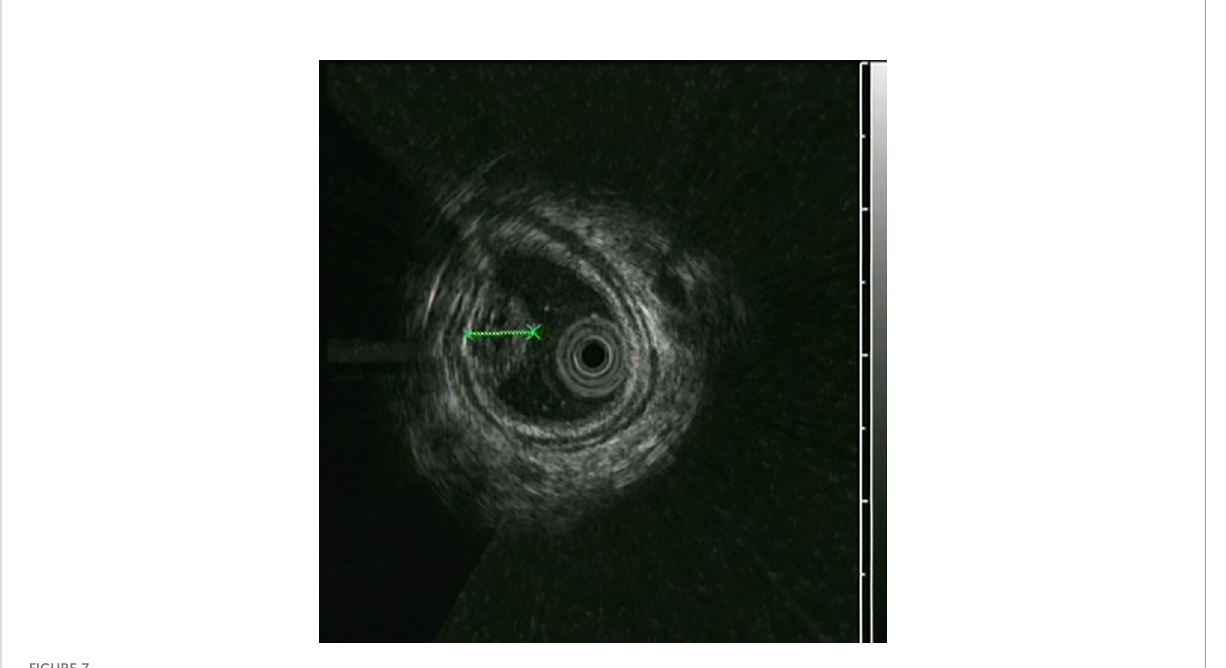
FIGURE 7 The esophageal lymphangioma was characterized by a heterogeneous